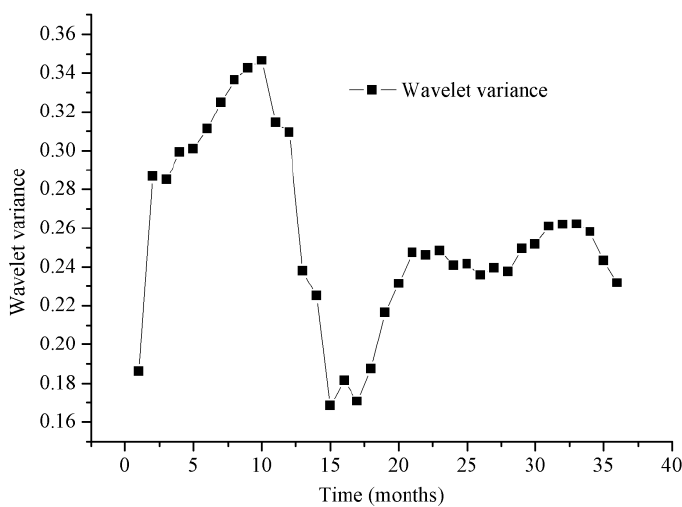
cycle; the third peak value corresponds to 33 months. This shows that the fluctuation of the above three periods controls the variation characteristics of monthly PM 2.5 concentration in Liaocheng.